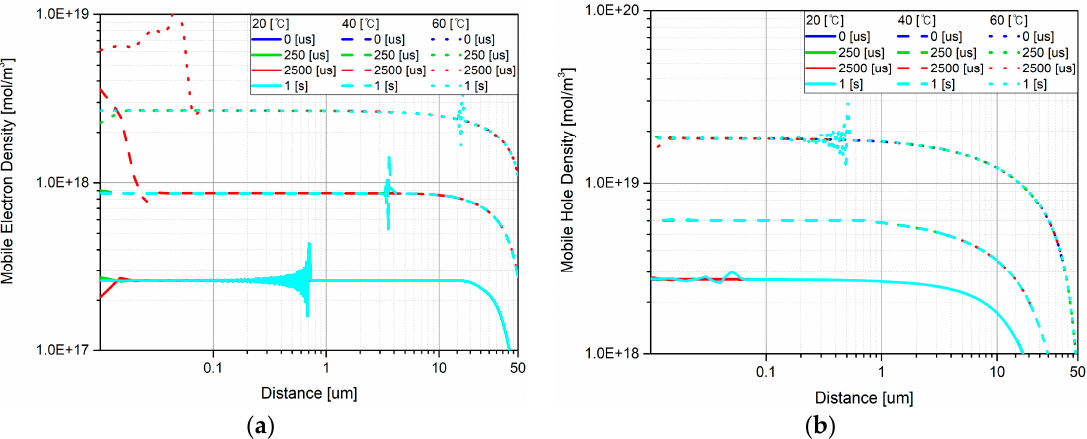
Figure 9. Mobile carrier density immediately after switching impulse is superimposed on prestressed DC voltage: (a) mobile electrons; (b) mobile holes.